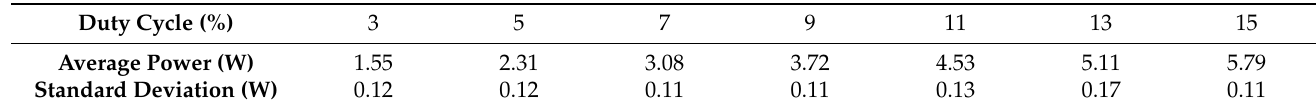
Table 3. Actual average power at different duty